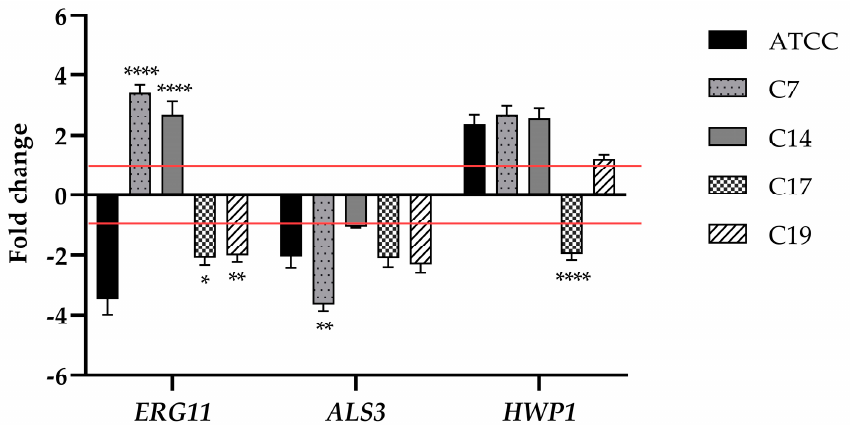
Figure 6. Expression analysis of selected genes of Candida albicans using real-time qPCR ( ERG11, ALS3 , and HWP1 ) in response to PLA. Histograms represent the fold differences in the expression levels of the genes selected during inhibition of biofilm with PLA at concentration of 2.5 mg mL − 1 . Red lines show fold change thresholds of − 1 and +1, respectively. * p < 0.05, ** p < 0.01, *** p < 0.001, and **** p < 0.0001 vs. C. albicans (Tukey’s test).